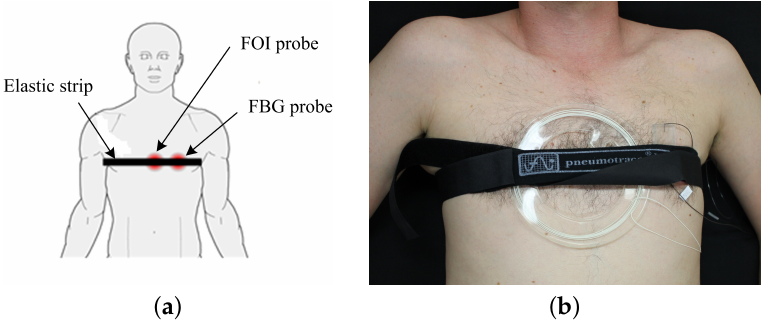
Figure 8. ( a ) a schematic location of the fibre-optic probes on the human body; ( b ) a photo of the location of the fibre-optic probes on subject M1 in the supine body